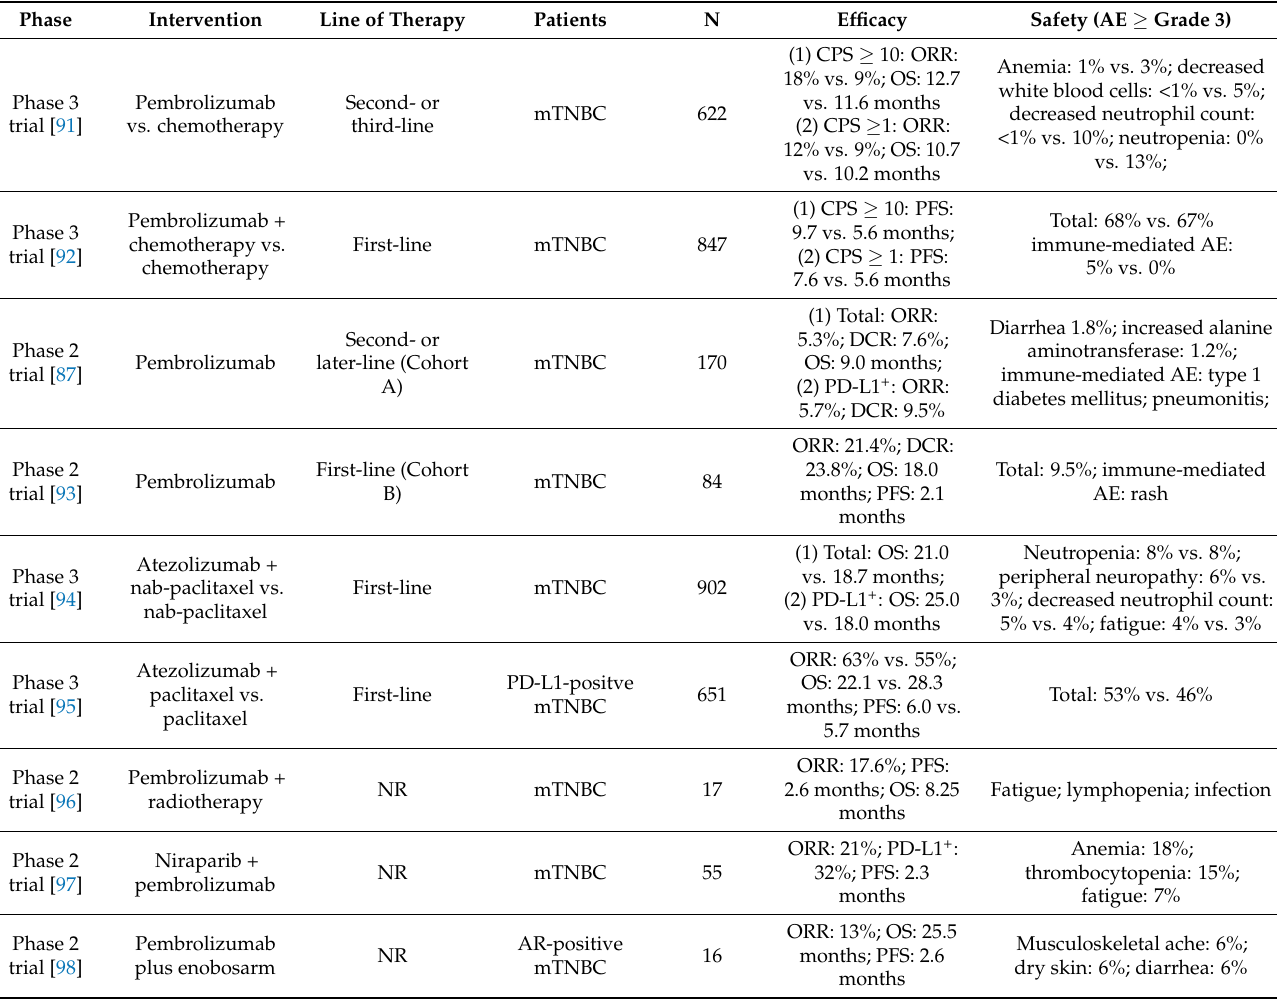
Table 3. Clinical trials of ICIs approved for